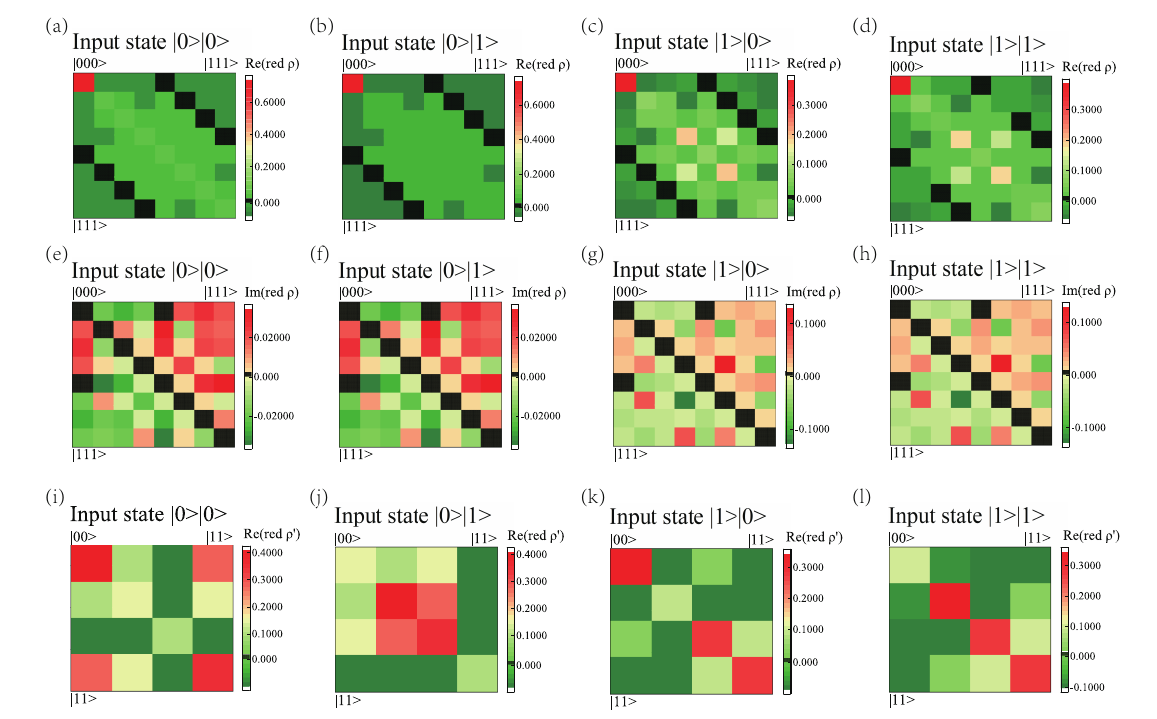
Figure A2. ( a – d ) The real parts of reduced density matrices of the first register. ( e – h ) The imaginary parts of reduced density matrices of the first register. ( i – l ) The real parts of reduced density matrices of the second register. Table A1. Coordinates of elements with absolute zero values and maximum values in density